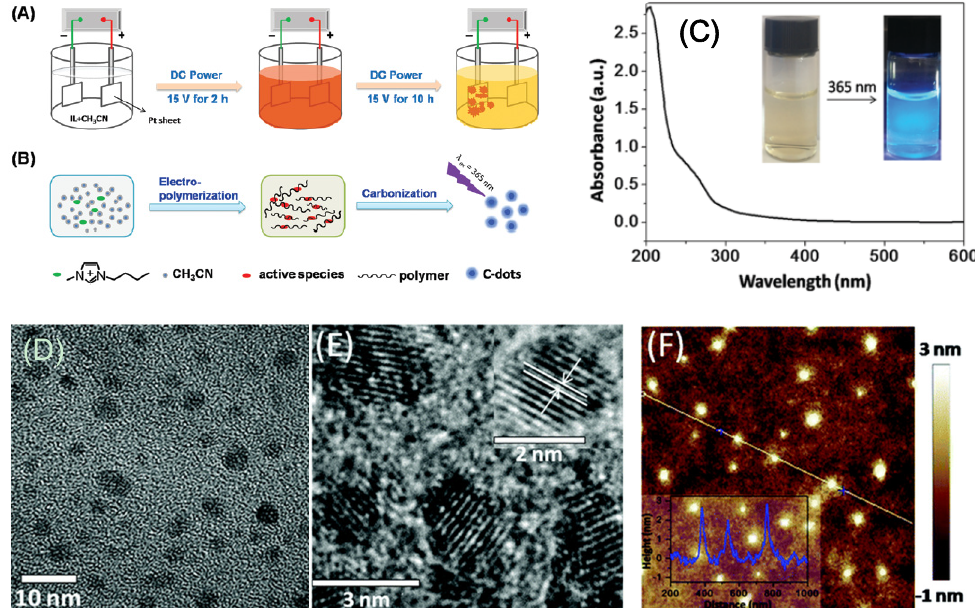
Figure 2. ( A ) Schematic illustration for carbon dot (CD) synthesis via the electrochemical strategy. ( B ) Mechanism of CD synthesis. ( C ) UV-VIS absorption spectrum of CD. In the inset, left and right photographs were for as-synthesized CDs under visible and UV (excited at 365 nm) light, respectively. ( D ) Transmission electron microscopic (TEM), ( E ) high resolution transmission electron microscope (HR-TEM), and ( F ) atomic force microscopic (AFM) topography images of CDs synthesized from BMIMPF 6 / acetonitrile at ratio of 1:500 on a silicon substrate with a height profile (inset)—Reproduced with permission from [23] published by The Royal Society of Chemistry,